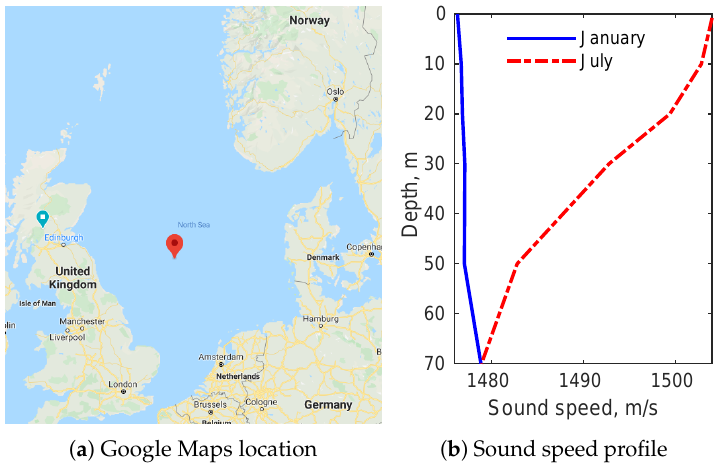
Figure 3. Sound speed profile (SSP) examples in January and July, based on the temperature, pressure and salinity data in the North Sea at (55.5 ◦ N, 2.5 ◦